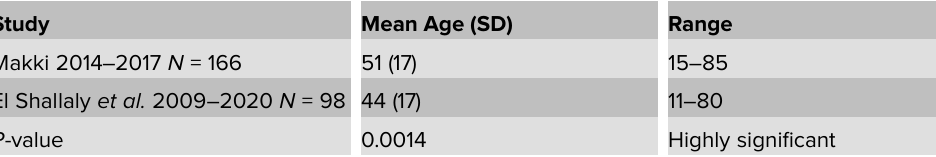
Table 4: Comparison of mean age (SD) of patients with thyroid